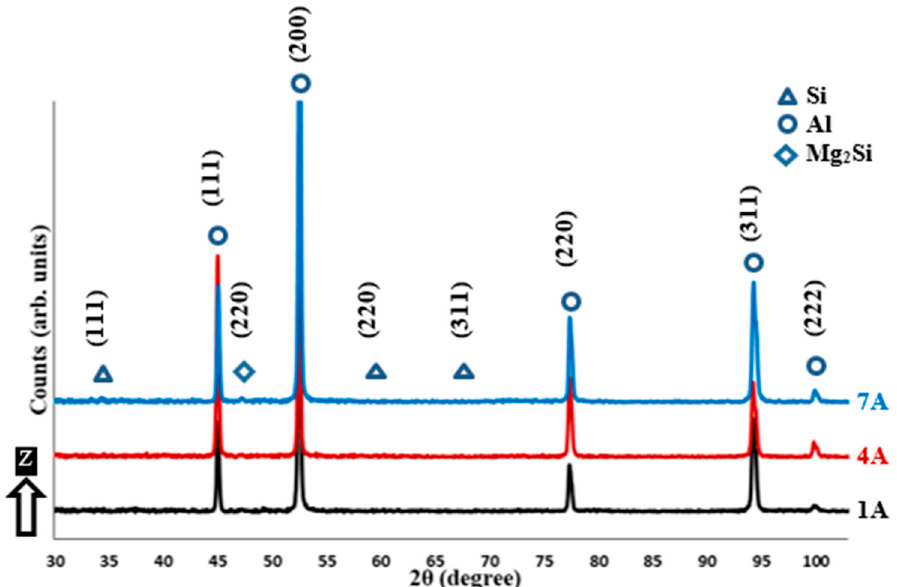
Figure 8. XRD phase pattern measured on the side surface (along the Z-direction) of different as-built Al6061 samples.